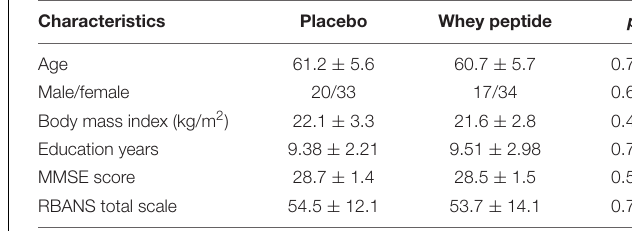
TABLE 1 | Subject characteristics at baseline (week 0).